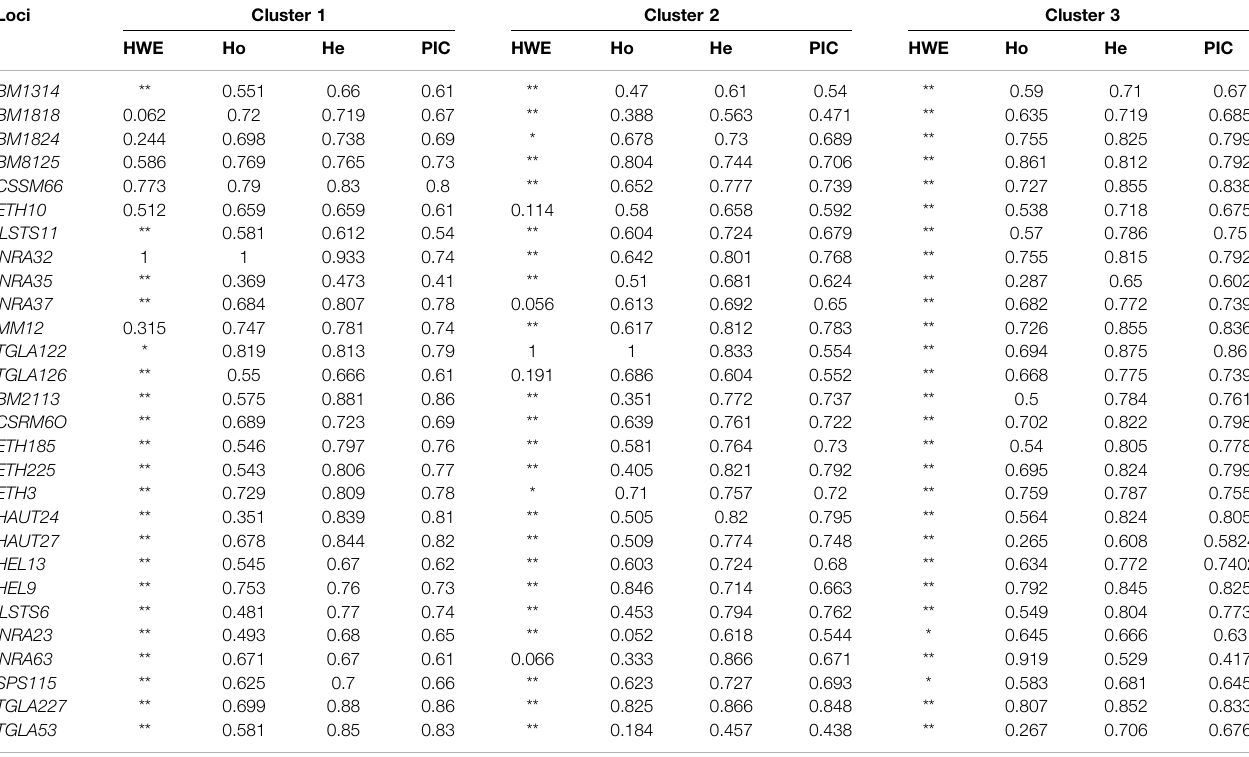
TABLE 5 | Heterozygosity of microsatellite loci for breed characterization of Curraleiro Pé-Duro cattle. Loci Cluster 1